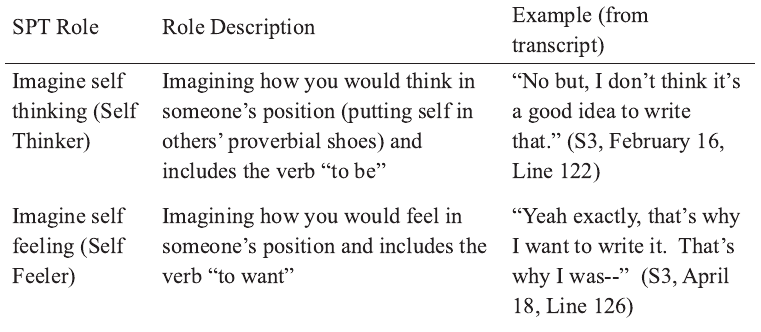
SPTRoles With Associated Descriptions and Examples SPT